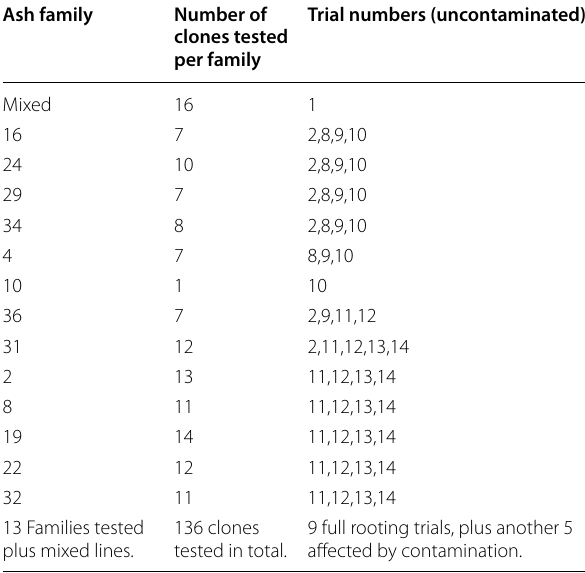
Table 1 The family sets of proliferating ash shoot cultures used in rooting trials for this study Ash family